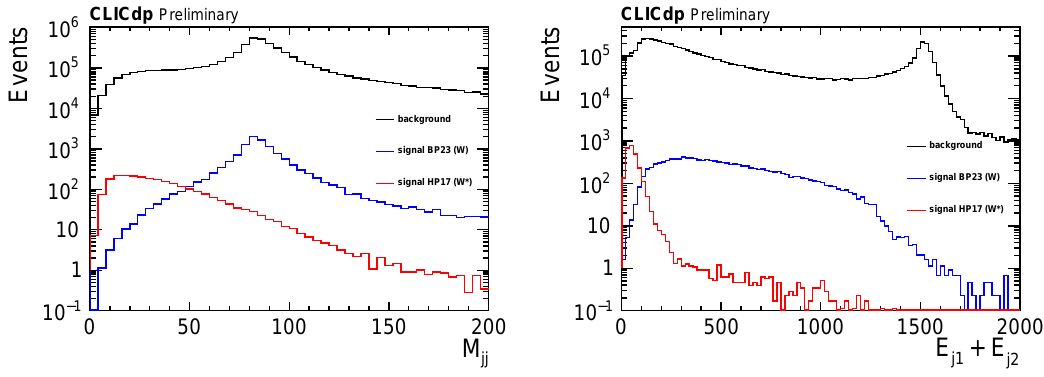
Figure 1: Histograms of the mass (left) and the energy (right) of a dijet system, ob- (cid:112) s = 3 TeV. The red line denotes HP17, and the blue tained using fast simulation, for one BP23. Black histogram is the sum of all SM background channels. Normalization is the number of events expected in the real